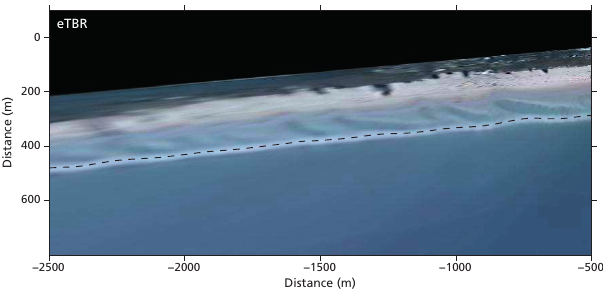
rLTT Figure 4. Example of the characteristic sandbar morphology during the straightening of a shore-attached crescentic sandbar to a shore- parallel linear bar by obliquely incident waves. Here, the barline (dashed line) straightens and the rip channels become obliquely ori- ented. Adapted from: Price and Ruessink